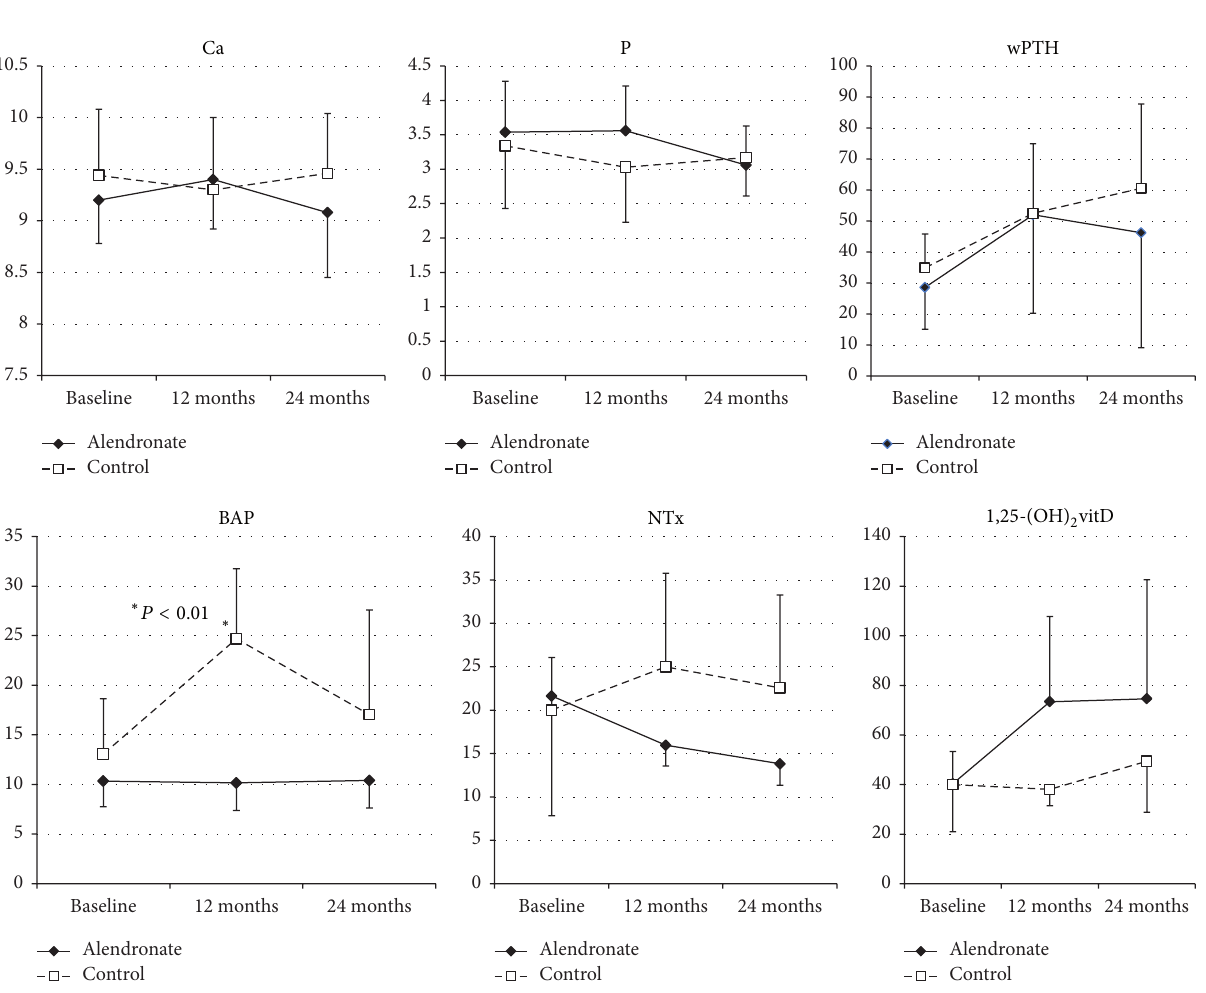
Figure 1: Baseline and follow-up values of parameters in bone turnover